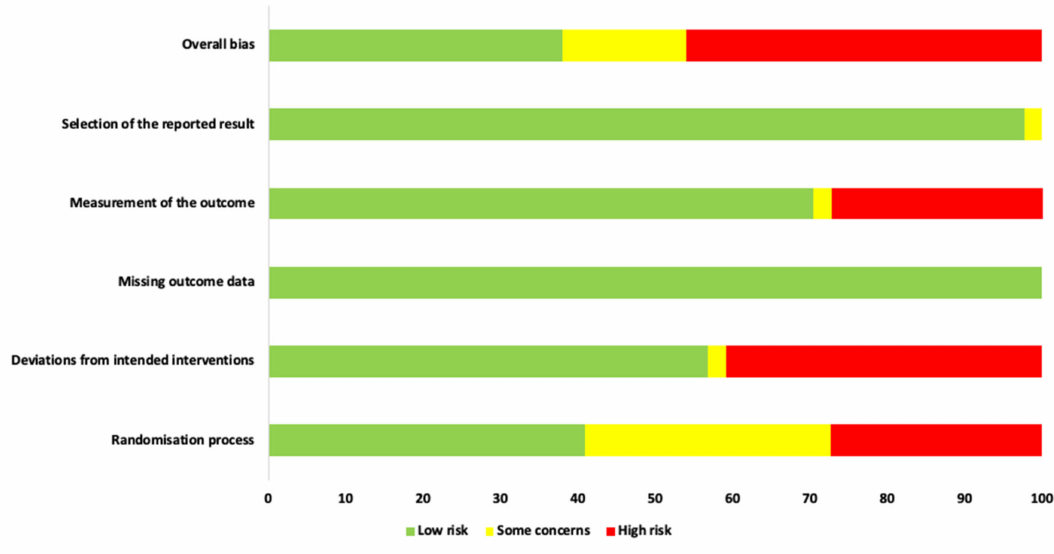
Figure 4. Risk of Bias assessment graph of the included studies expressed as percentages based on the consensual answers of two individual assessors (R.H. and